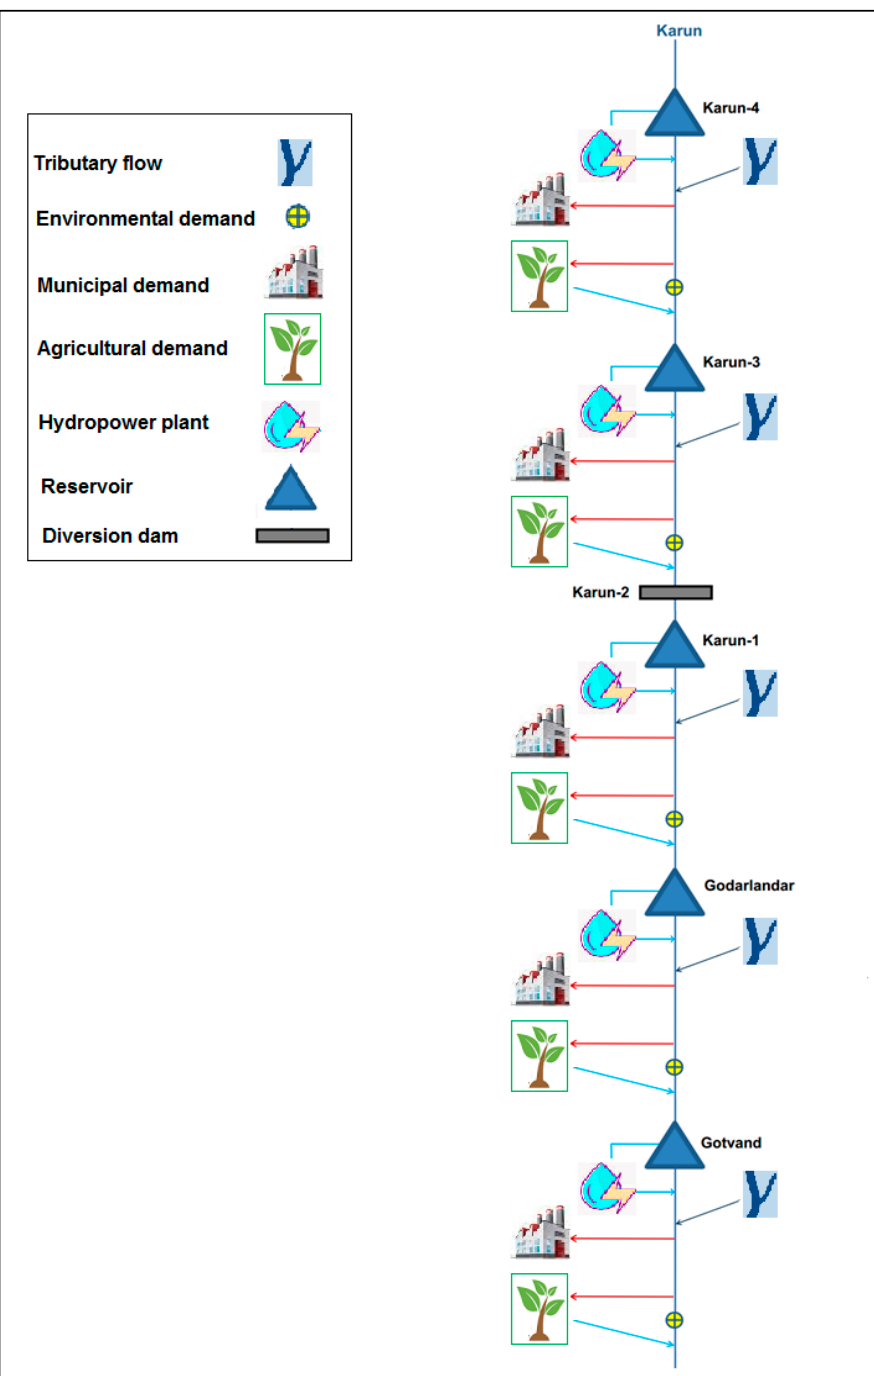
Figure 6. Schematic diagram of the system.